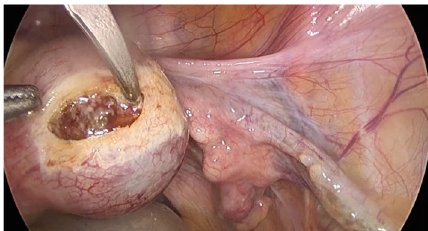
Figure 4: Curvilinear incision to the surface of ectopic mass, exposing underlying trophoblastic tissue.